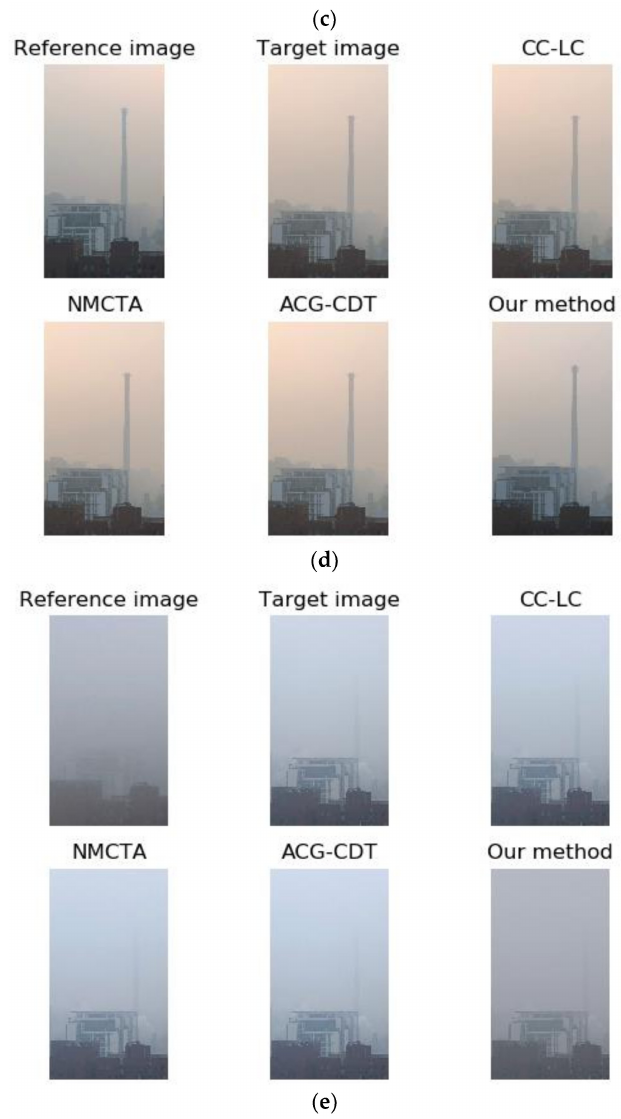
Figure 17. Comparison of different color correction methods. ( a ) is the comparison of different algorithms when the level is excellent; ( b ) is the comparison of different algorithms when the level is good; ( c ) is the comparison of different algorithms when the level is light; ( d ) is the comparison of different algorithms when the level is moderate; ( e ) is the comparison of different algorithms when the level is